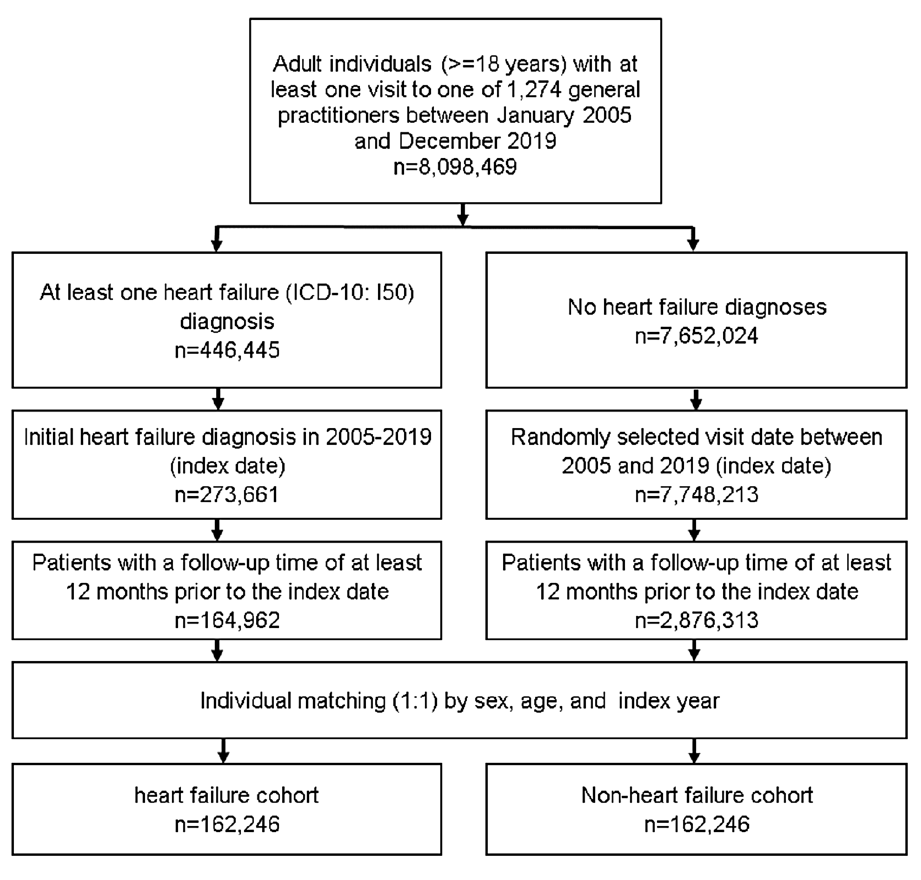
Figure 1. Selection of study